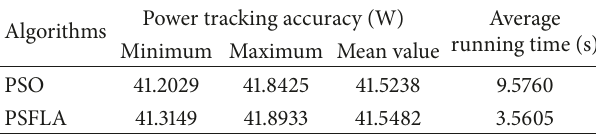
Table 4: The experiment summary result for test 2.